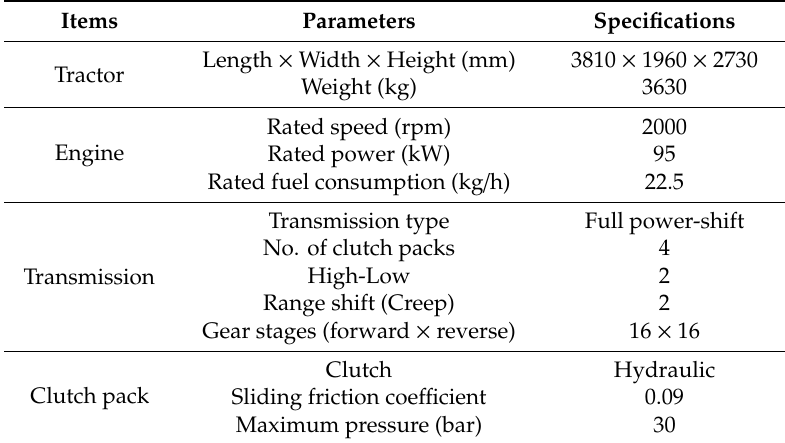
Table 1. The specifications of the tractor used in this study.